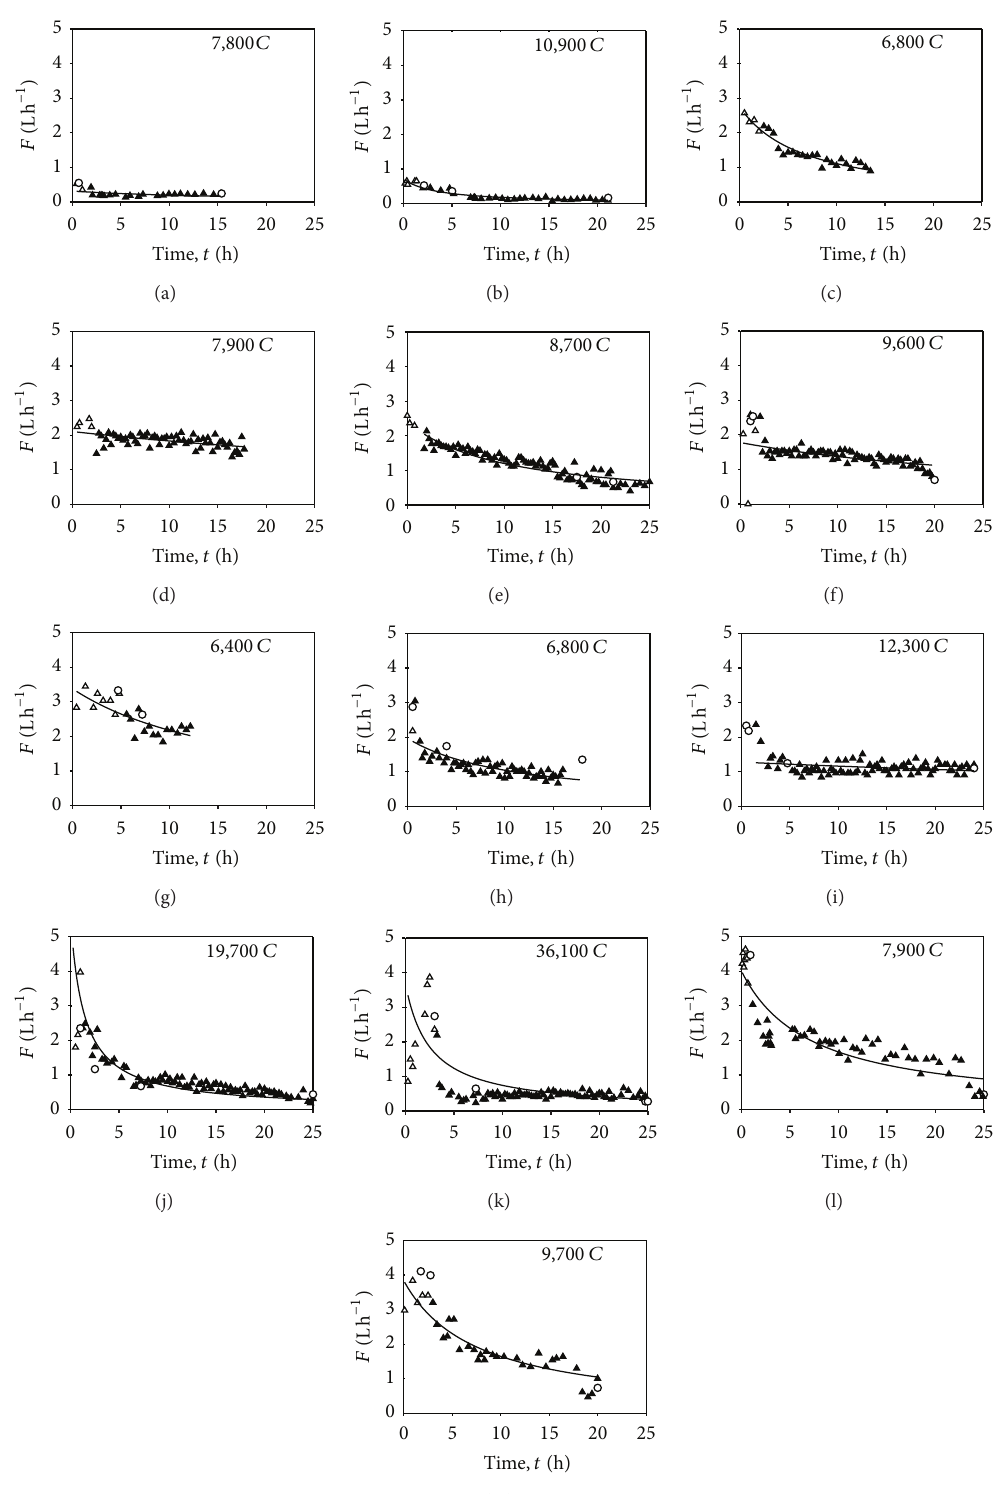
Figure 5: Mytilus edulis . Mean individual filtration rate ( 𝐹 , 󳵳 ) measured by the fluorometer controlled apparatus (FCA) in 4 groups of mussels (Group I = (a) and (b); Group II = (c), (d), (e), (f), and (g); Group III = (h), (i), (j), (k), and (l); Group IV = (m), see Table 1). The mussels were initially exposed to a relatively low algal ( Rhodomonas salina ) concentration ( △ , about 2,300 cells mL −1 ) to measure the maximum filtration rate, whereupon the algal concentrations were increased to different higher levels as indicated in the subfigures ( 𝐶 , cells mL −1 ). Supplementary, filtration rates were regularly measured by the clearance rate method ( ⃝ ,